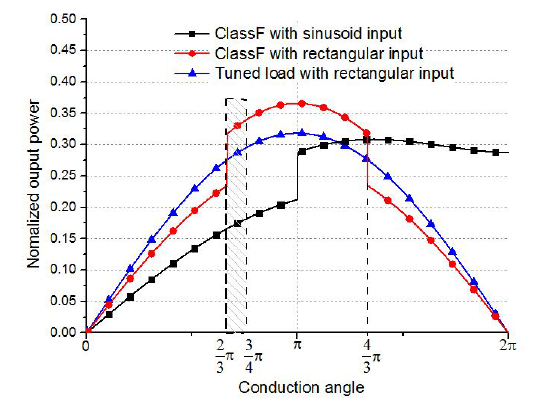
Figure 4. Output power with respect to the useful biasing range of class-C-F